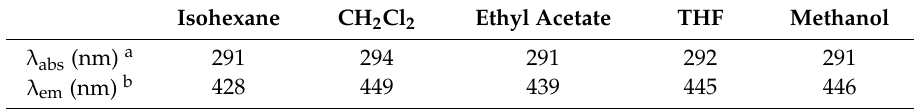
Table 3. UV absorption and fluorescence emission data of the naphthidine 4 in di ff erent solvents.